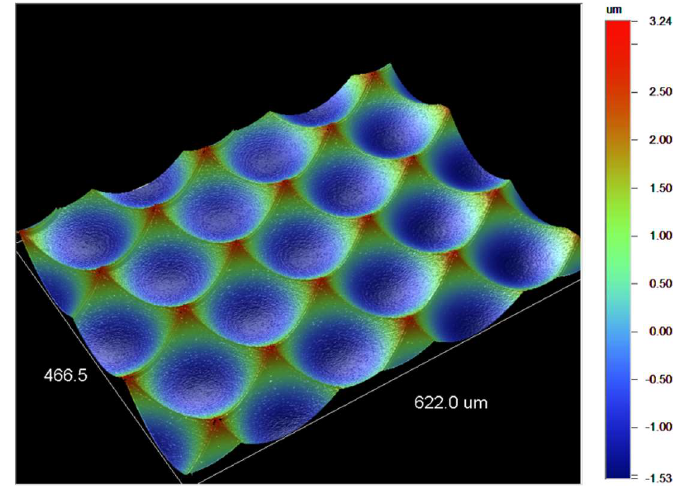
Figure 5. Micro lens array fabricated by means of diamond milling measured by white light interferometry (WLI).